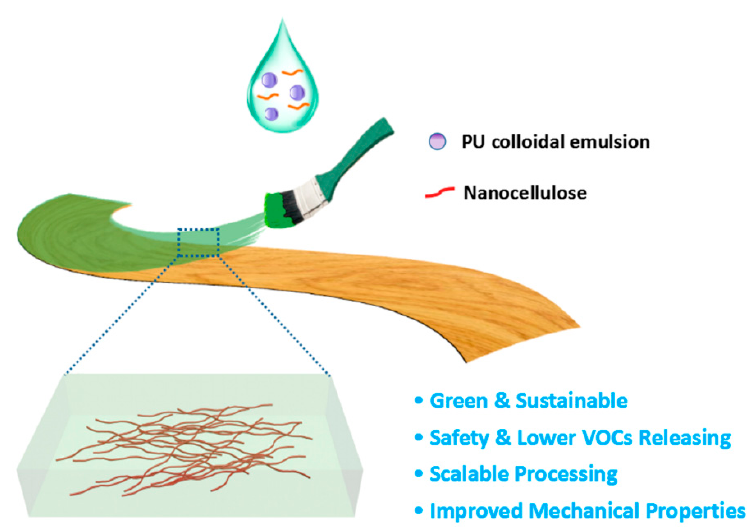
Figure 1. Schematic illustrations of nanocellulose-reinforced waterborne polyurethane as wood coating.